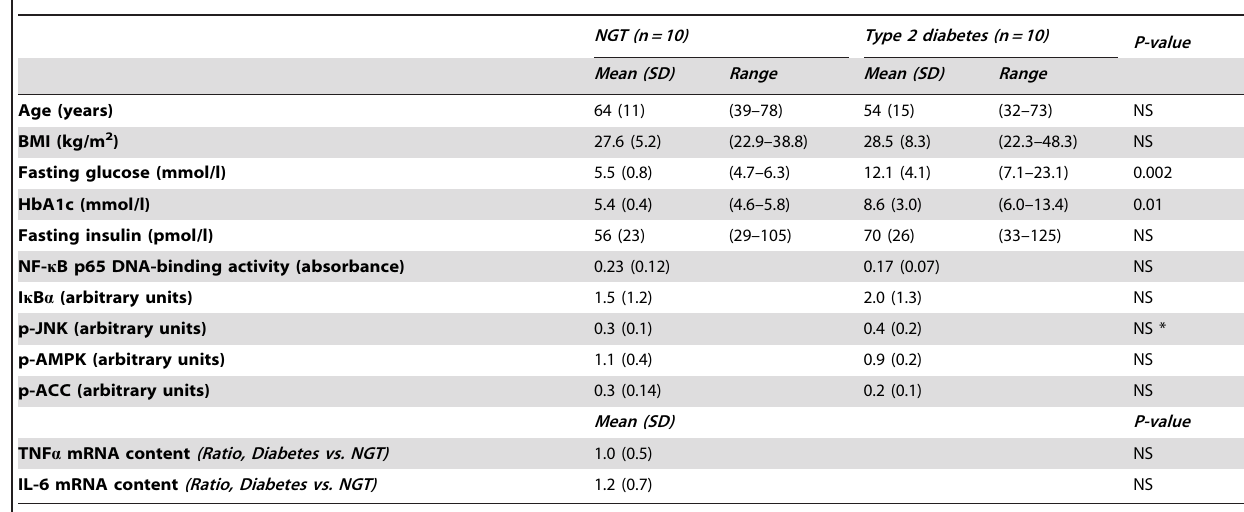
Table 1. Baseline